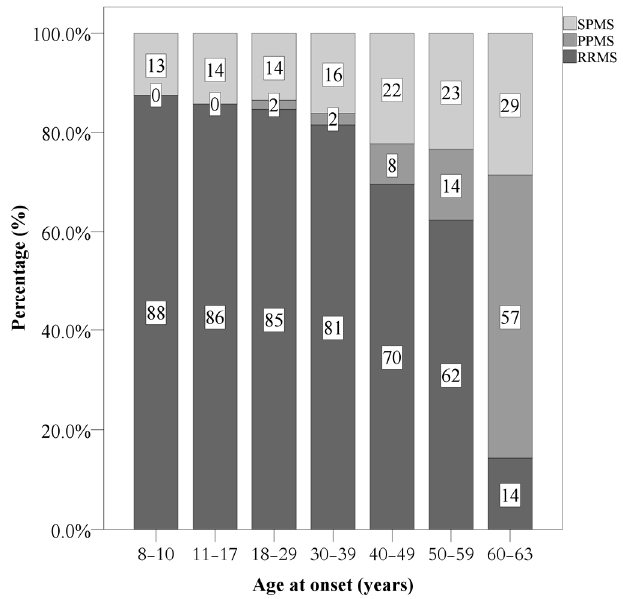
Figure 3. Frequency of disease courses at the last visit, separately for age categories at disease onset. RRMS = relapsing remitting MS. PPMS = primary progressive MS; SPMS = secondary progressive MS.